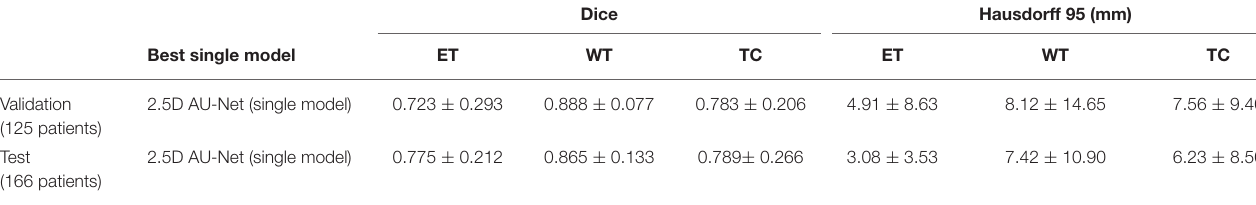
TABLE 2 | Results of the 2.5D AU-Net model proposed to BraTS 2019 validation data (125 cases) and testing data (166 patients) using our best single model.